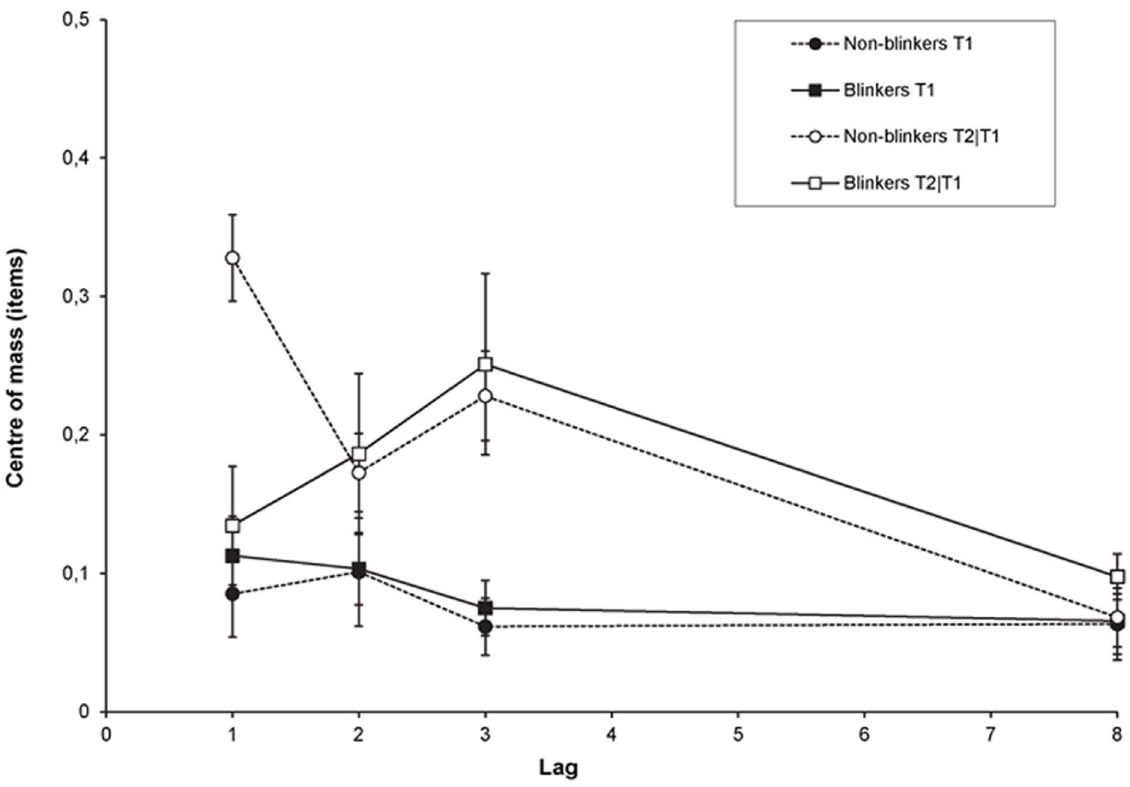
Figure 5. Delay in Experiment 1b. Delay of the temporal selection process expressed as the centre of mass of reports in the selection window around a given target as a function of lag, for blinkers and non-blinkers. doi:10.1371/journal.pone.0066185.g005 PLOS ONE |